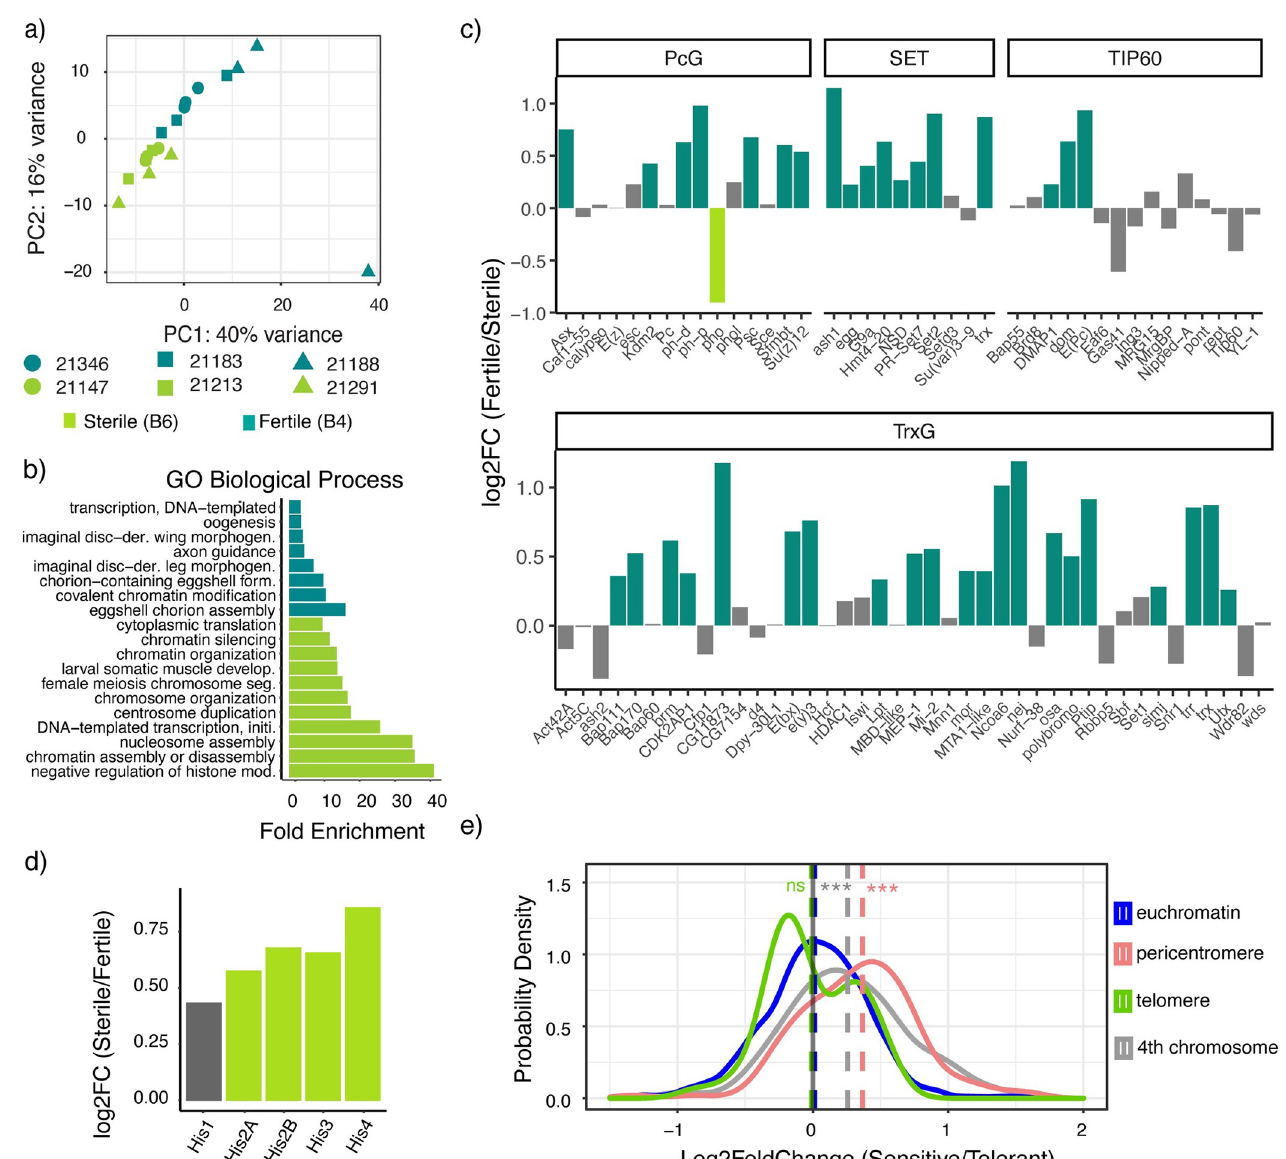
Fig 2. Fertility is associated with increased chromatin modification, whereas sterility is associated with increased expression of replication-dependent histones. a ) PCA analysis of gene expression data for pairs of sterile (B6) and fertile (B4) RILs, that carry founder B6 and B4 haplotypes across the QTL window. Members of the same RIL pair with otherwise similar genetic backgrounds are represented by the same shape. b) GO terms enriched among genes upregulated in fertile and sterile genotypes. c) Log2 fold differences in expression for chromatin modifiers between sterile and fertile genotypes. d) Log2 fold increase in RD histone expression in sterile genotypes. e) . Probability density plot of log2 fold change values for all euchromatic (blue), pericentromeric (red), telomeric (green) genes and 4th chromosome (gray) between strains carrying sterile and fertile. The mean of each distribution is represented by a dotted line, and is compared between distributions with a two-sample t -test. The x-axis boundaries were confined from (-1.5 to 2) for a better visualization. The pericentromere-euchromatin boundaries were drawn from [29,45]and subtelomeric-euchromatin boundary coordinates from [46–48].The data represented in panel a is provided in S14 Table and plot in panels c, d, and e in S5 Table ). ��� denotes P <